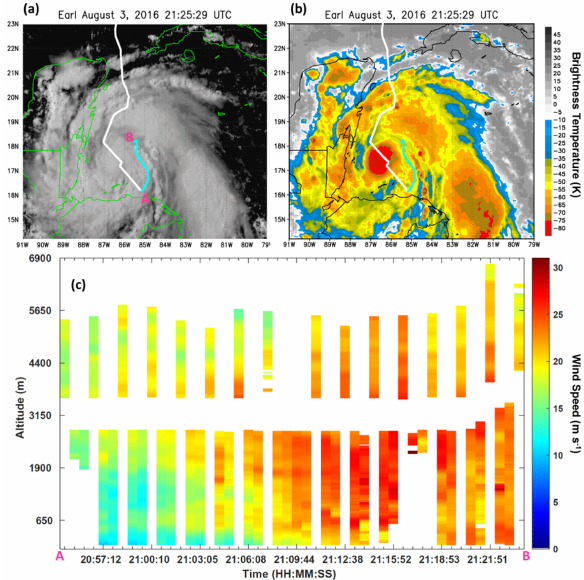
Figure 9. ( a ) Visible and ( b ) IR satellite imagery of Hurricane Earl at 2125 UTC 3 August 2016 with the P-3 flight track overlaid (white) and the downwind leg (cyan). Star denotes the TC center. ( c ) ADWL wind speed profiles collected during the downwind leg of the